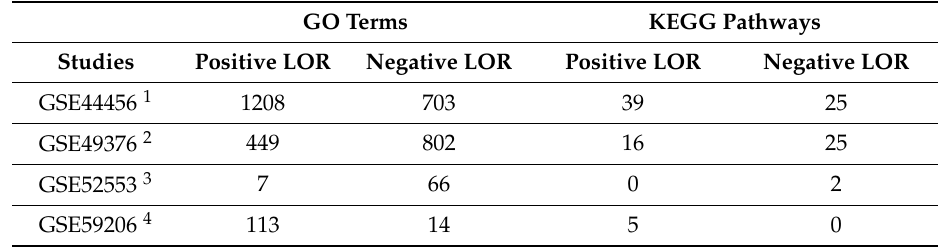
Table 2. Number of significant GO terms and Kyoto Encyclopedia of Genes and Genomes (KEGG) pathways in each study after applying GSEA. Positive and negative LOR represent overrepresentation in women with AUD and men with AUD,